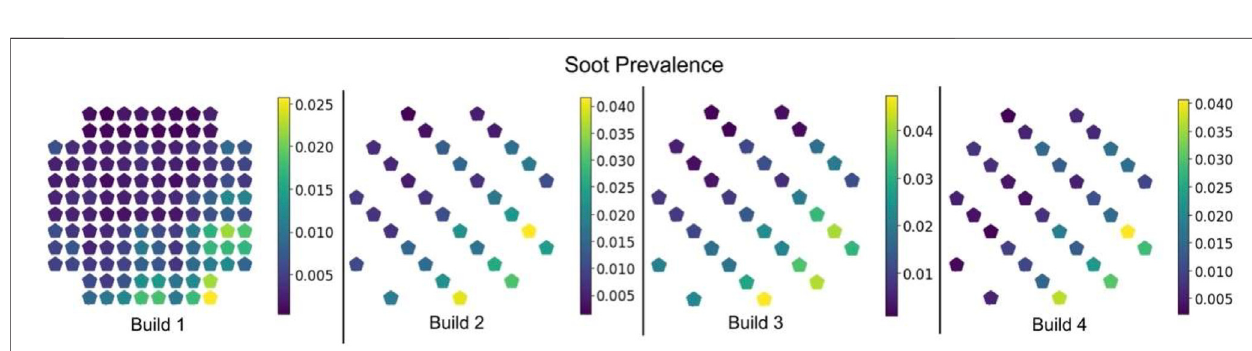
FIGURE 8 | Visualization of balanced accuracy per component of each build for the “ Log ” input feature set.